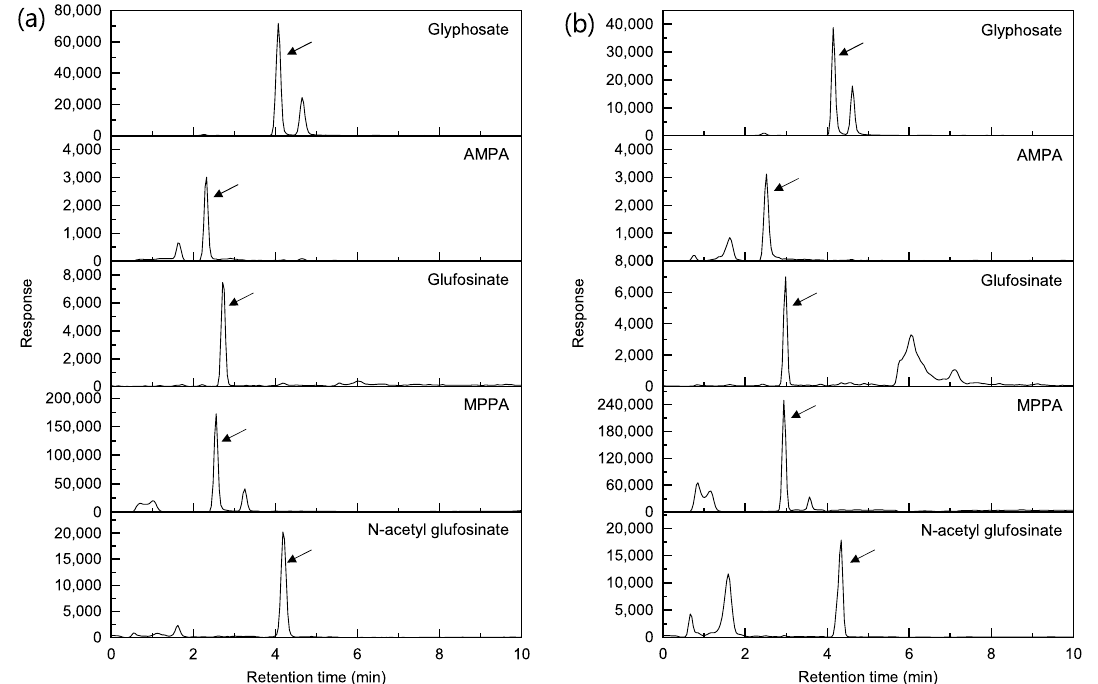
Figure 2. The extracted ion (quantitative ion) chromatograms obtained from one (5 ng/mL) of matrix matched standards of each pesticide (glyphosate (167.9 > 62.9), aminomethylphophonic acid (AMPA) (110.0 > 79.0), glufosinate (179.9 > 62.9), 3-methylphosphinico-propionic acid (MMPA) (150.9 > 132.9), and N -acetyl glufosinate (222.0 > 135.9) using (a) the anionic polar pesticide column and (b) the Torus DEA column.